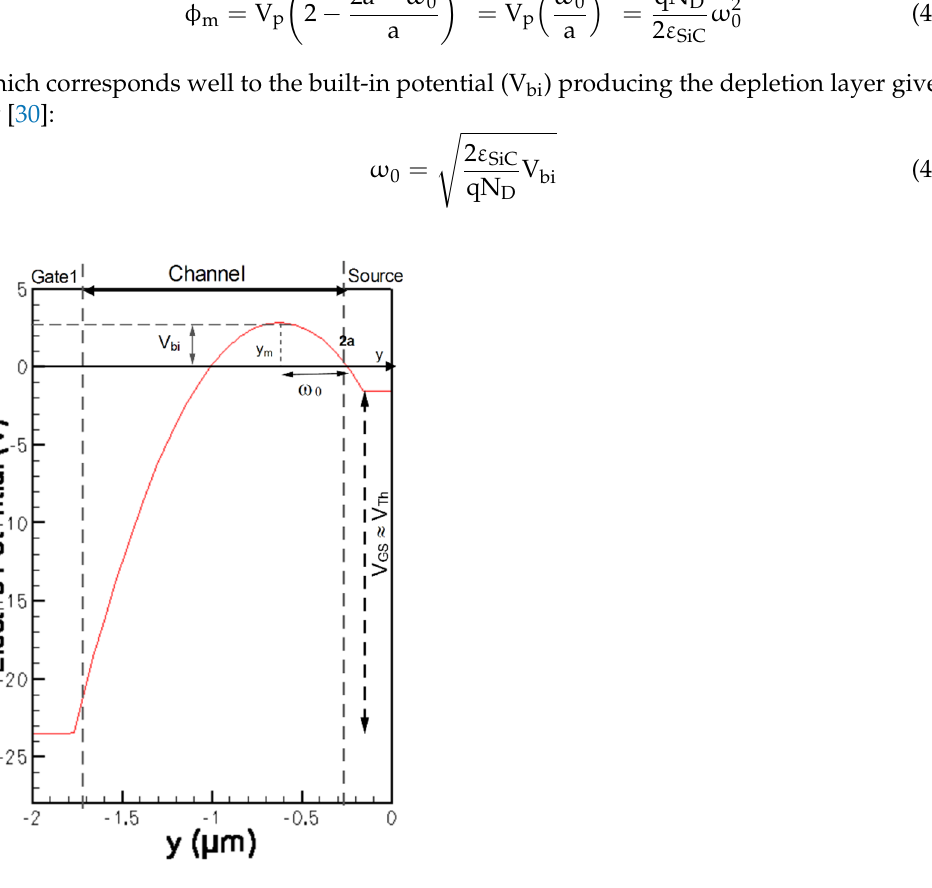
Figure 6. Numerical simulation of the electric Potential distribution along the lateral channel of the SiC LC-VJFET structure.